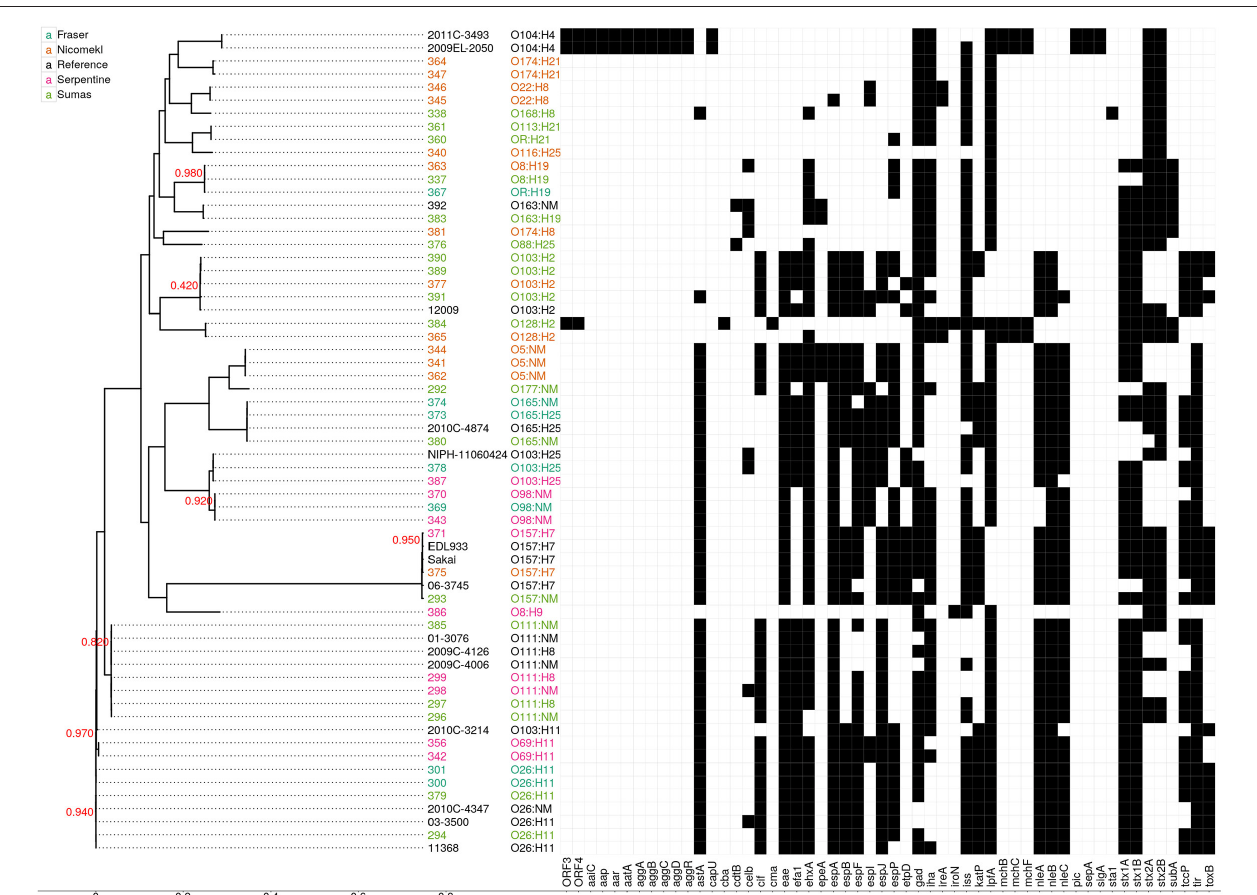
FIGURE 3 | Approximate maximum likelihood tree and presence/absence matrix for 54 acquired virulence factor genes detected in 63 STEC genomes, including 48 from the present study and 15 reference genomes from clinical isolates. The phylogeny was generated using Parsnp with EDL933 as a reference. Node labels indicate local support values (range from 0 to 1) based on 1000 resamplings and the Shimodaira Hasegawa test in FastTree2. The tree was based on 118,086 core SNP loci and the scale corresponds to the number of substitutions per SNP. Isolate numbers and serotypes are assigned different colors according to source as shown in the legend. Black squares in the virulence factor matrix indicate the presence of a virulence gene in the Virulence Factor Database at a sequence identity of at least 72%, while white indicates the absence of the gene. Reference genomes: O103:H11 (2010C-3214), O103:H2 (12009), O103:H25 (NIPH-11060424), O104:H4 (2009EL-2050), O104:H4 (2011C-3493), O111:H8 (2009C-4126), O111:NM (01-3076), O111:NM (2009C-4006), O165:H25 (2010C-4874), O26:H11 (03-3500), O26:H1 (11368), O26:NM (2010C-4347), O157:H7 (EDL933), O157:H7 (Sakai). Virulence factor genes and their